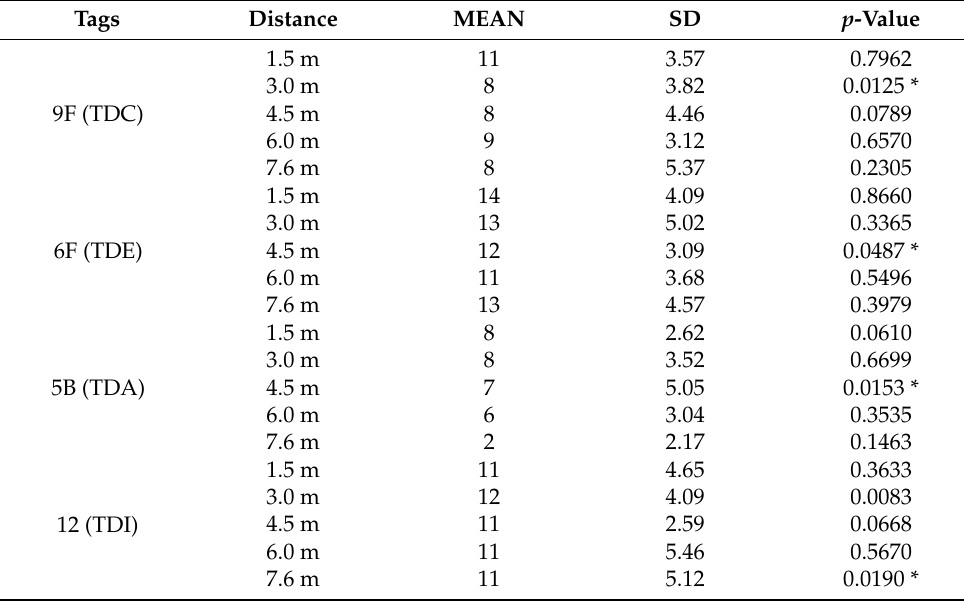
Table 7. Experimental results of the distance. Tags